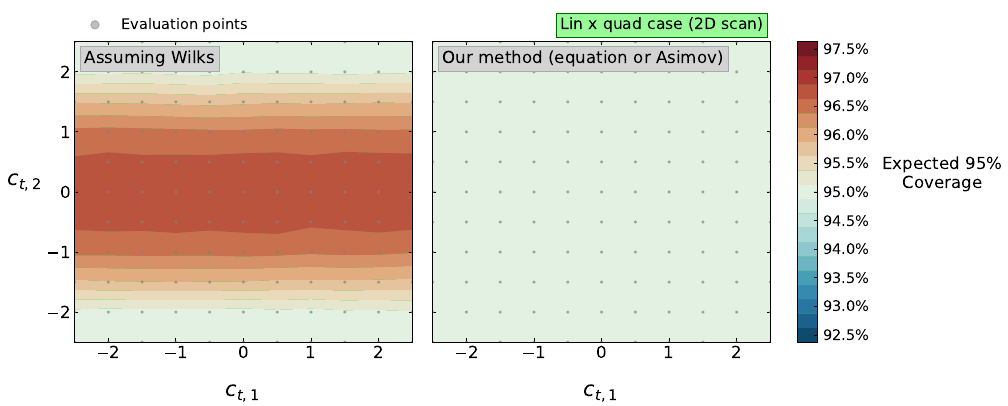
Figure 5: Expected 95% coverage assuming Wilks (left) and using our method (right) for a 2D example with ¯ l method provides correct coverage for | c